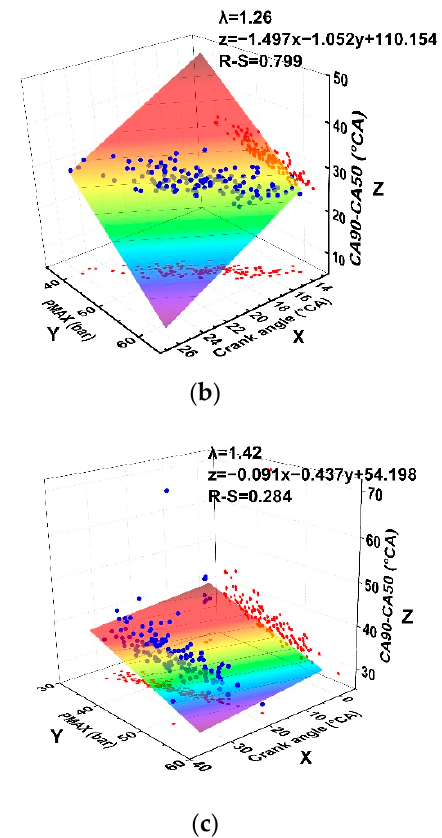
Figure 11. Fitting of CA90-CA50 and PMAX distribution under different λ : ( a ) The fitting of CA90-CA50 and PMAX at λ = 1.05; ( b ) The fitting of CA90-CA50 and PMAX at λ = 1.26; ( c ) The fitting of CA90-CA50 and PMAX at λ = 1.42. Table 10. Fitting parameters of CA90-CA50 and PMAX distribution under different λ .